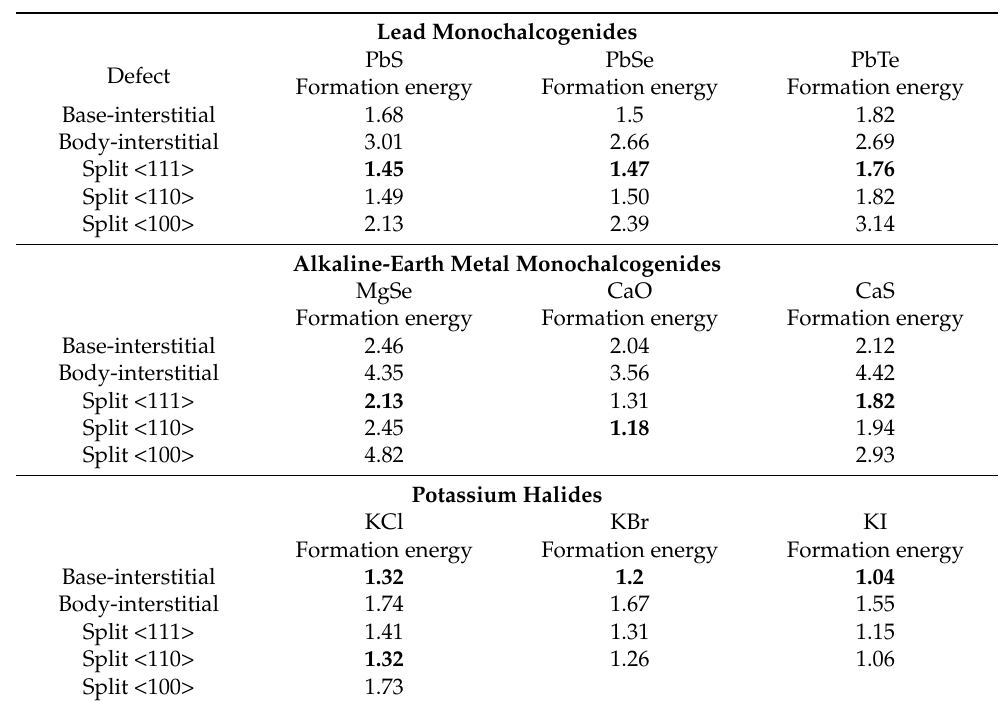
Table 2. Formation energies (eV) of anion interstitial configurations in rock-salt systems. The configuration with the lowest energy in each system is marked in